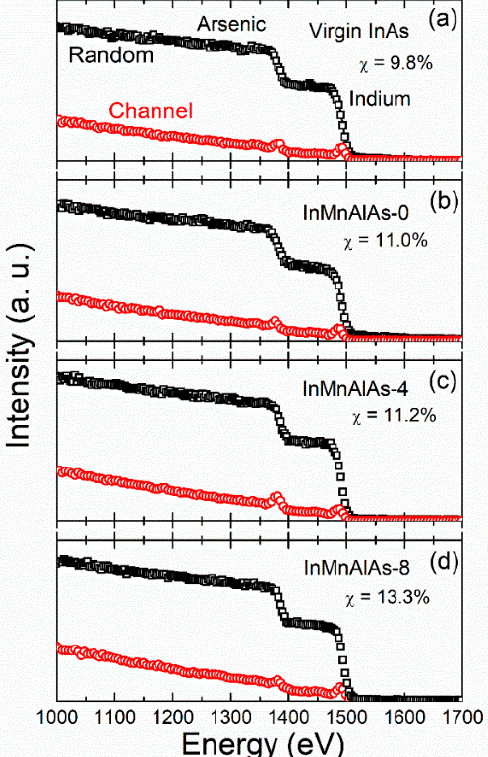
Figure 3. The RBS random (open squares) and channeling (open circles) spectra of samples: ( a ) virgin InAs; ( b ) InMnAlAs-0; ( c ) InMnAlAs-4; ( d ) InMnAlAs-8.